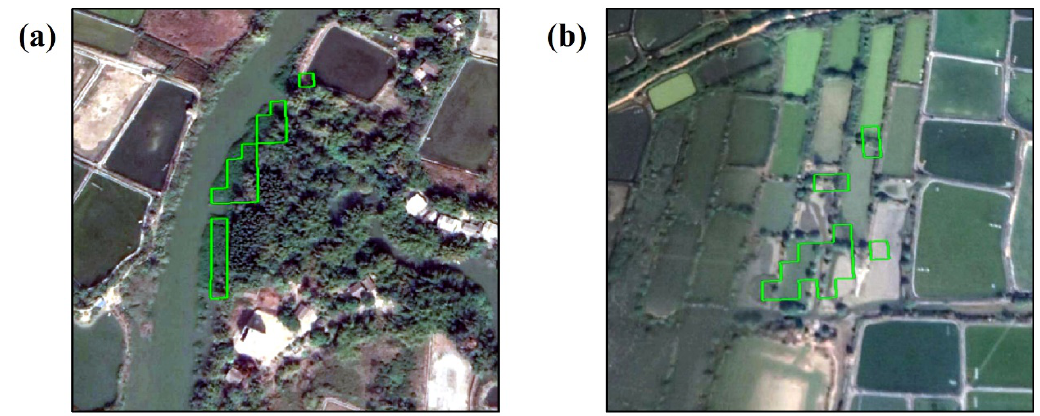
Figure 12. Misclassified pixels of our 10-m map at the edge of rivers ( a ) and ponds ( b ).